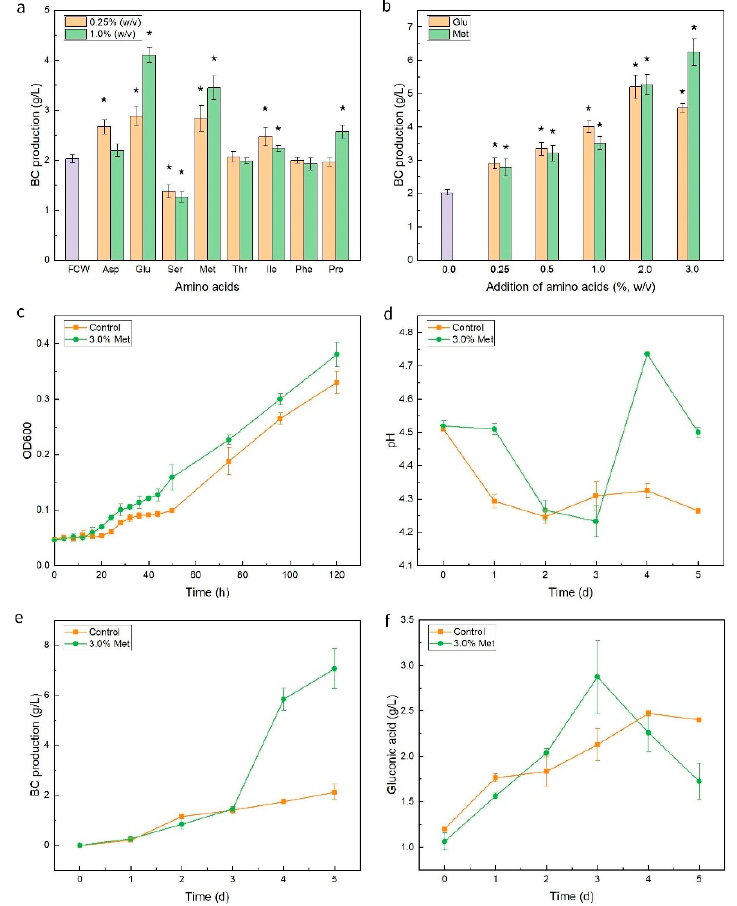
Figure 3. Effects of addition of selected amino acids on the production of BC ( a , b ), and addition of 3.0% ( w / v ) methionine on the synthesis of BC ( c – f ). Control: the BC membrane obtained in the FCW medium; 3.0% Met: the BC membrane obtained in the FCW medium with the addition of 3.0% methionine. Significant differences of the samples to the control group FCW without addition of amino acids were confirmed at * p < 0.05 (n = 3).